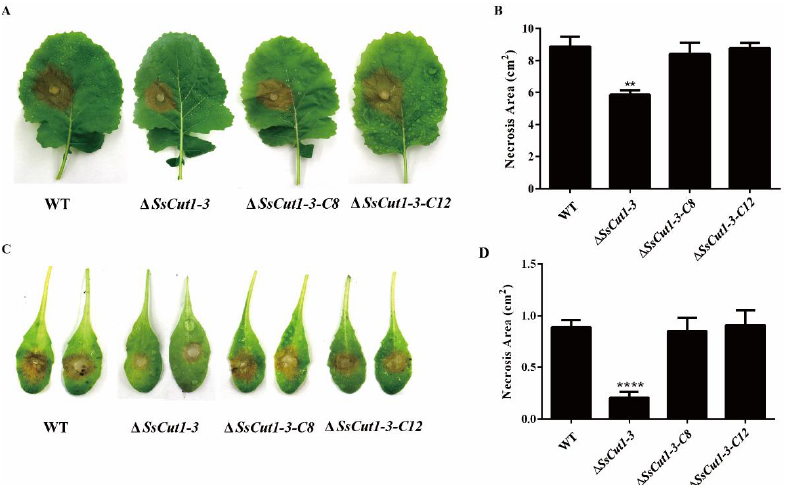
Figure 5. SsCut1 knock-out mutants showing reduced virulence on the detached leaves of oilseed rape and Arabidopsis leaves. ( A ) Lesions formation on oilseed rape leaves inoculated with wild-type strain (1980) and SsCut1 transformants, the photographs were taken at 48 h post-inoculation (hpi). ( B ) Statistical results of lesion area on oilseed rape leaves. ( C ) Lesions formation on A. thaliana leaves inoculated with wild-type strain and SsCut1 transformants, the photographs were taken at 36 hpi. ( D ) Statistical results of lesion area on A. thaliana leaves. Bars indicate ± SE ( n = 4). Statistical significance is indicated in the graph (one-way ANOVA): ** p < 0.01, **** p < 0.0001. The experiments were performed three times with similar results.